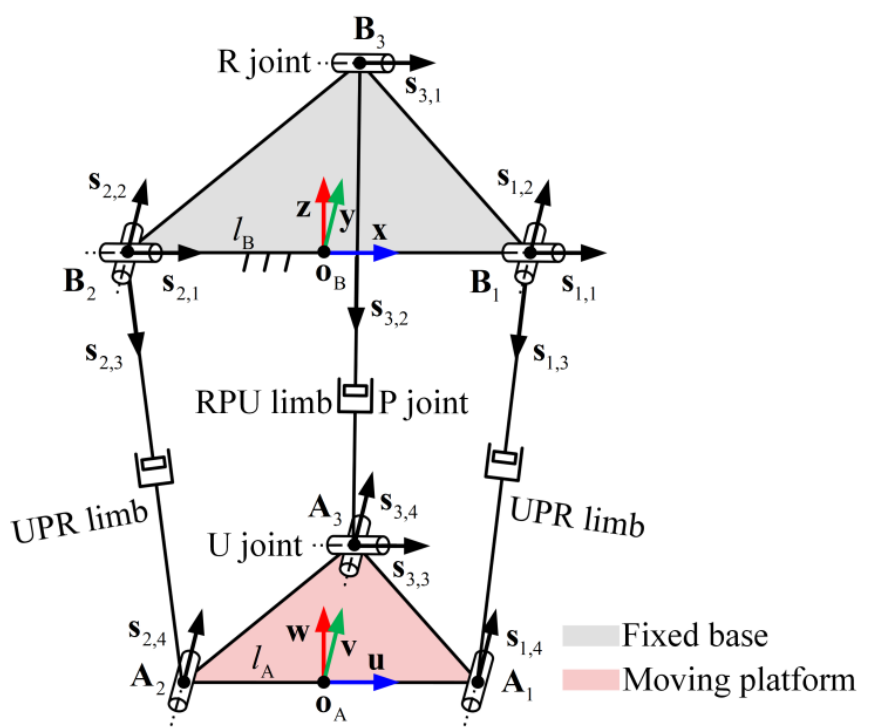
Figure 1. Schematic diagram of the 2UPR-RPU parallel mechanism.